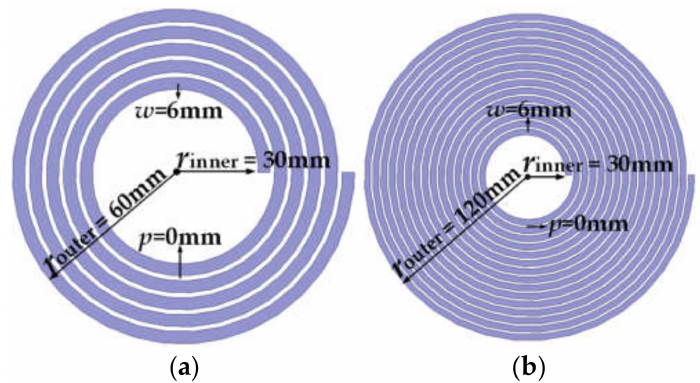
Figure 6. Outer radius and coil turns changing: ( a ) 5 turns; ( b ) 15